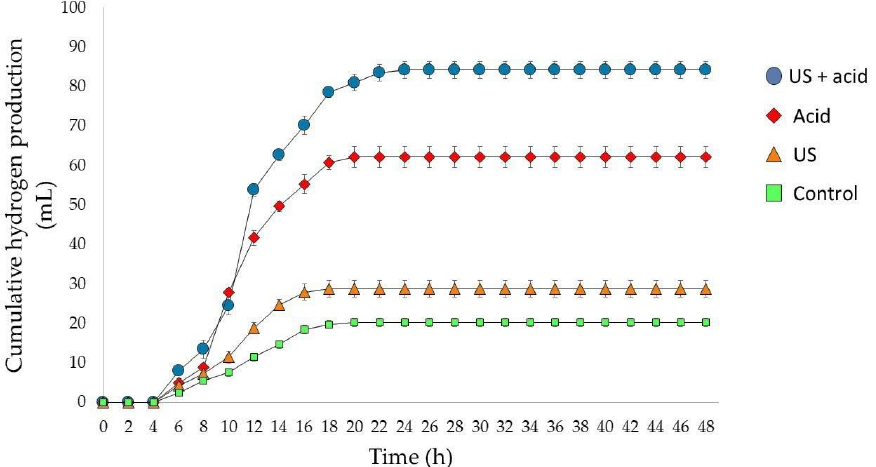
Figure 7. Cumulative hydrogen production for control and pretreated groups.